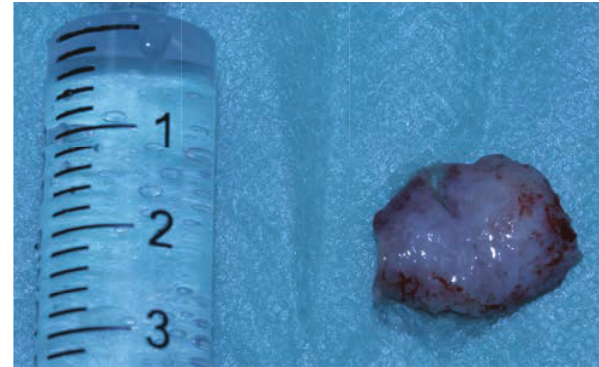
Figure 5b: Patient K. M, aged 19. Material taken for histopathologi- cal examination.